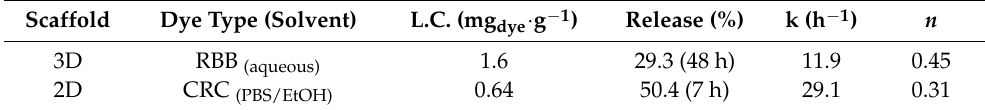
Figure 9. In vitro release profiles of RBB and CRC dyes and the plotted results obtained by application of Korsmeyer–Peppas model. Table 3. In vitro dye adsorption/release, sorption, and kinetic parameters.